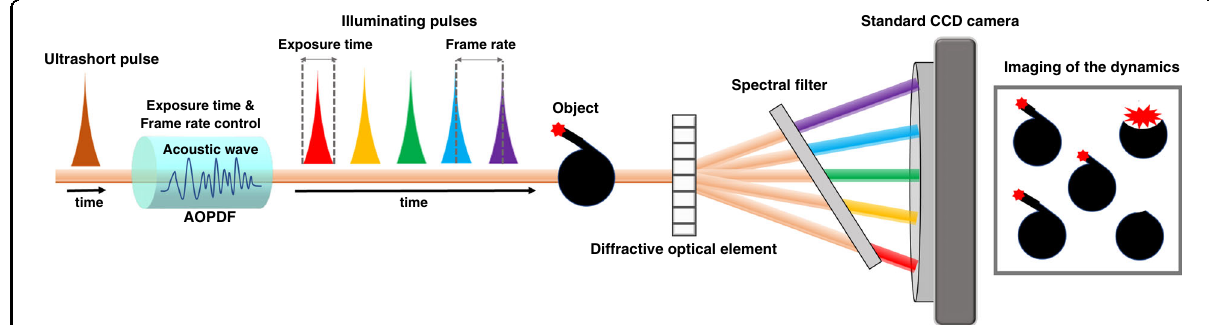
Fig. 1 Principle of the lensless ultrafast optical imaging. Acousto-optic programmable dispersive fi lter (AOPDF) performs pulse shaping on an ultrashort pulse, generating a pulse train. Each daughter pulse within the pulse train works a single frame encoding the imaging information and is spatially separated from other daughter pulses. All the daughter pulses are fi nally projected onto different areas of the camera